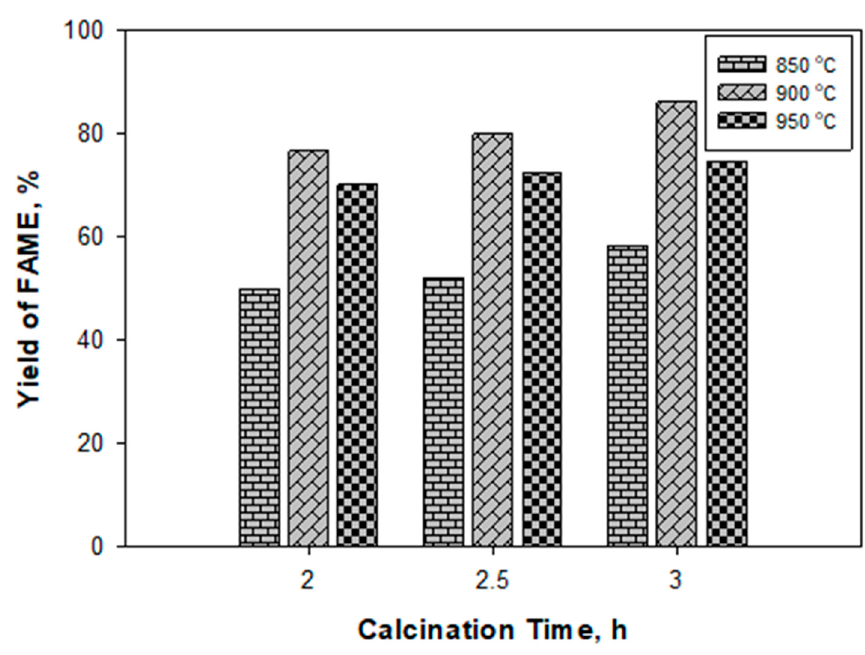
Figure 5. The influence of the temperature and time of the calcination process on the activity of the obtained CaO/FA catalyst for fatty acid methyl ester (FAME) production.